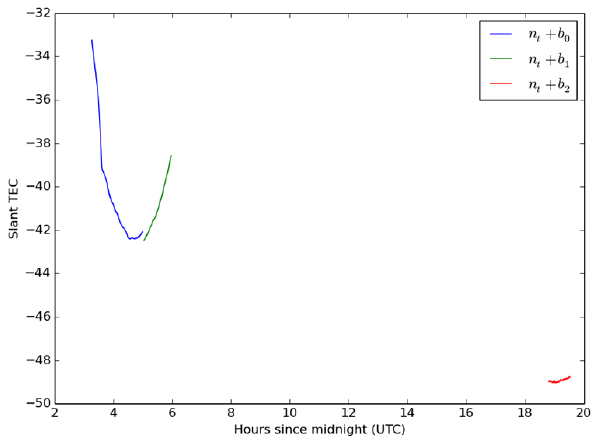
Figure 3. An example of a measurement of a single satellite col- lected by a single receiver. A loss of phase lock occurs during the first pass of the satellite, resulting in two receiver biases for that pass ( b 0 : blue curve; b 1 : green curve). During the next pass, a drift in the receiver bias could have occurred, so another receiver bias ( b 2 : red curve) is determined when the satellite is measured during the end of the